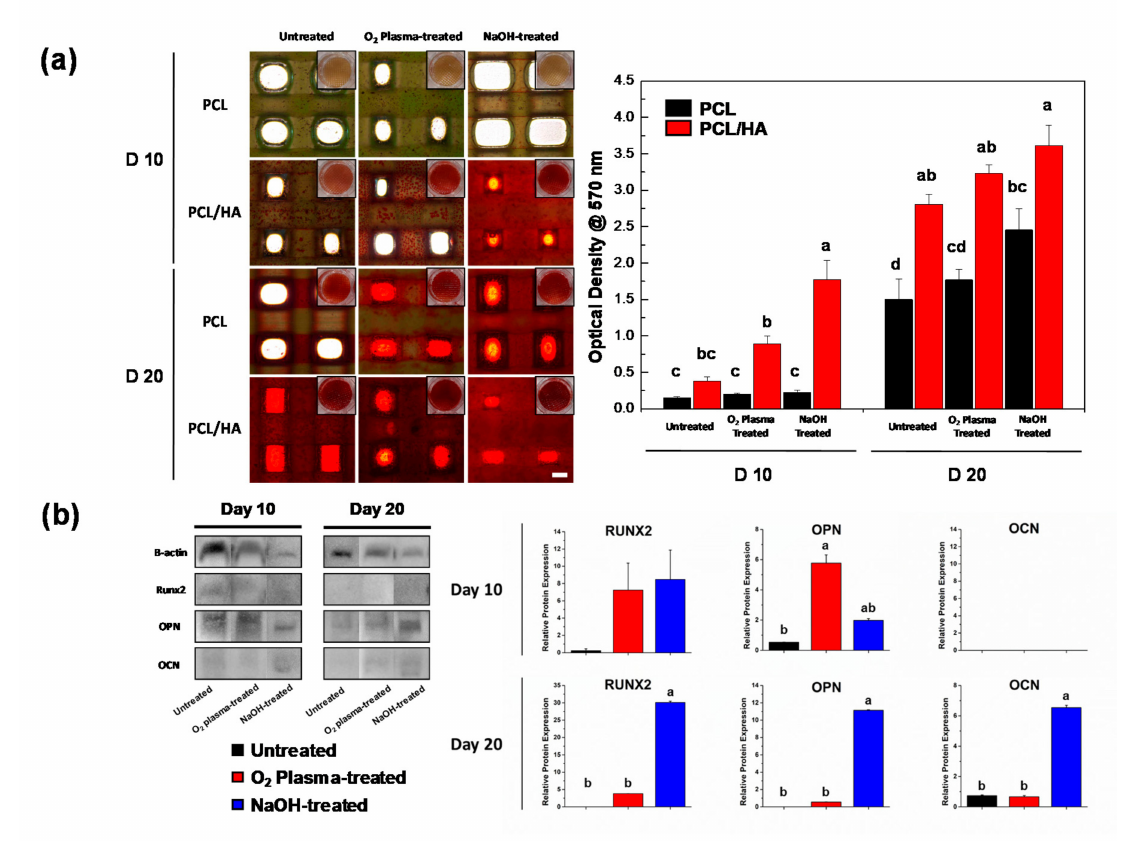
Figure 4. Osteogenic differentiation of hDPSCs on the scaffolds ( a ) Alizarin Red S staining of the hDPSCs cultured on the scaffolds on days 10 and 20. The quantitative data was obtained using de-staining (scale bar: 500 µ m). The NaOH-treated PCL/HA group exhibited enhanced calcium deposition. Same letters indicate that there is no significant difference between samples. ( b ) The expression of osteogenic proteins on the PCL/HA scaffolds (RUNX2, OPN, and OCN) was determined by Western blotting on days 10 and 20. Quantitative results showed significantly enhanced RUNX2, OPN, and OCN expression on the NaOH-treated PCL/HA scaffold. (n = 3, ANOVA, Duncan’s multiple range test, p < 0.05). Same letters indicate that there is no significant difference between